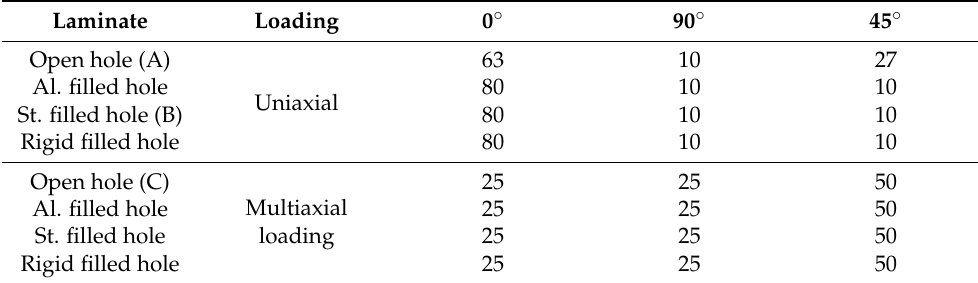
Table 4. Recommended percentages of plies for maximum load